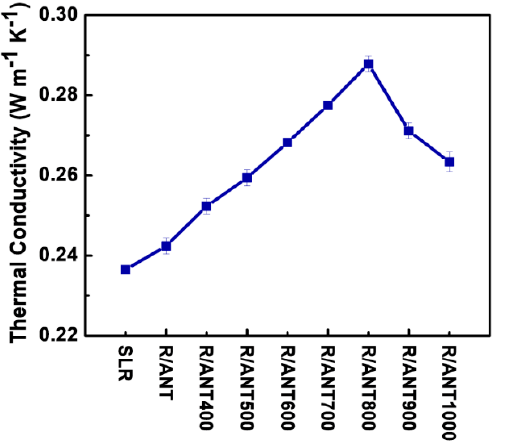
Figure 12. The thermal conductivity analysis of 3D printed samples of neat SLR and SLR/nanofillers.